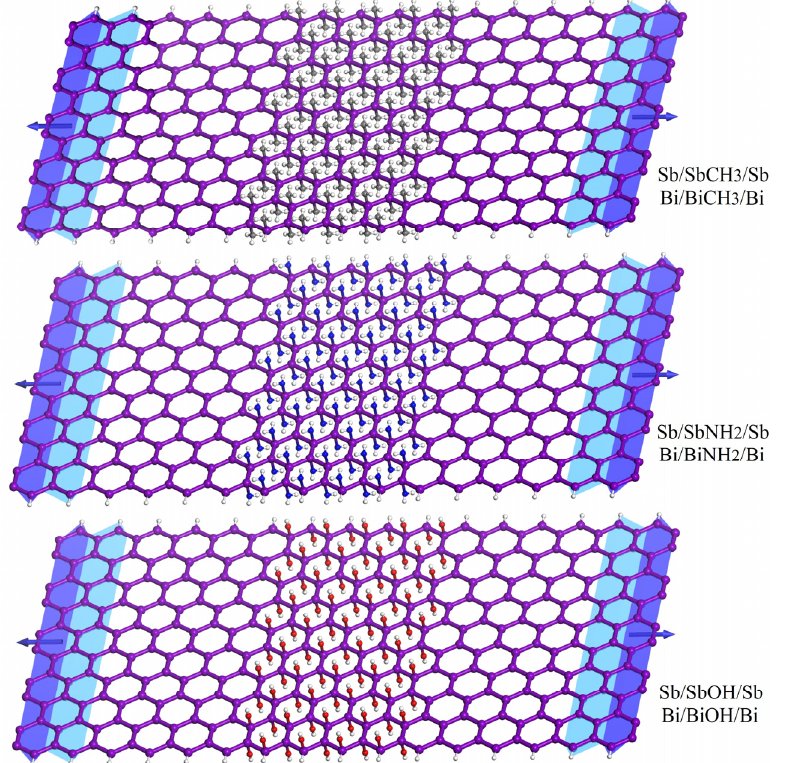
Figure 1. Bipolar transport device models of Sb/SbXH n /Sb or Bi/BiXH n /Bi double-heterostructure RRTs, where two semi-infinite electrodes are specified at two terminals of Sb or Bi monolayer nanoribbons. Purple, gray, blue, red and white spheres represent the chemically bonding atoms of Sb or Bi, carbon, nitrogen, oxygen and hydrogen respectively. Shallow blue and deep blue colors indicate buffer and electrode regions respectively.